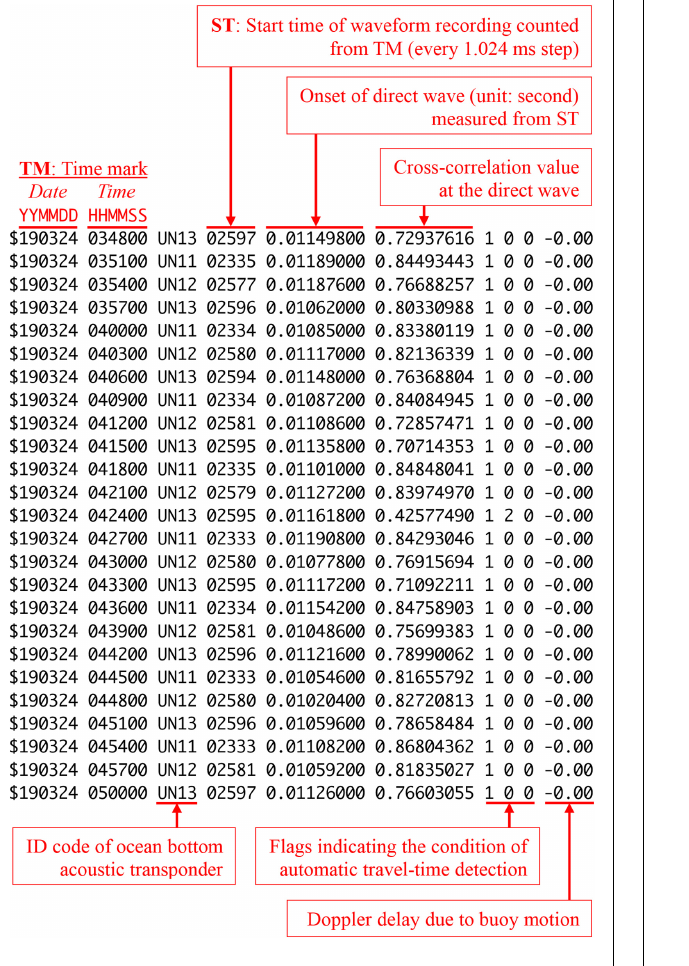
FIGURE 7 | Example of acoustic ranging data received at the ground base station.